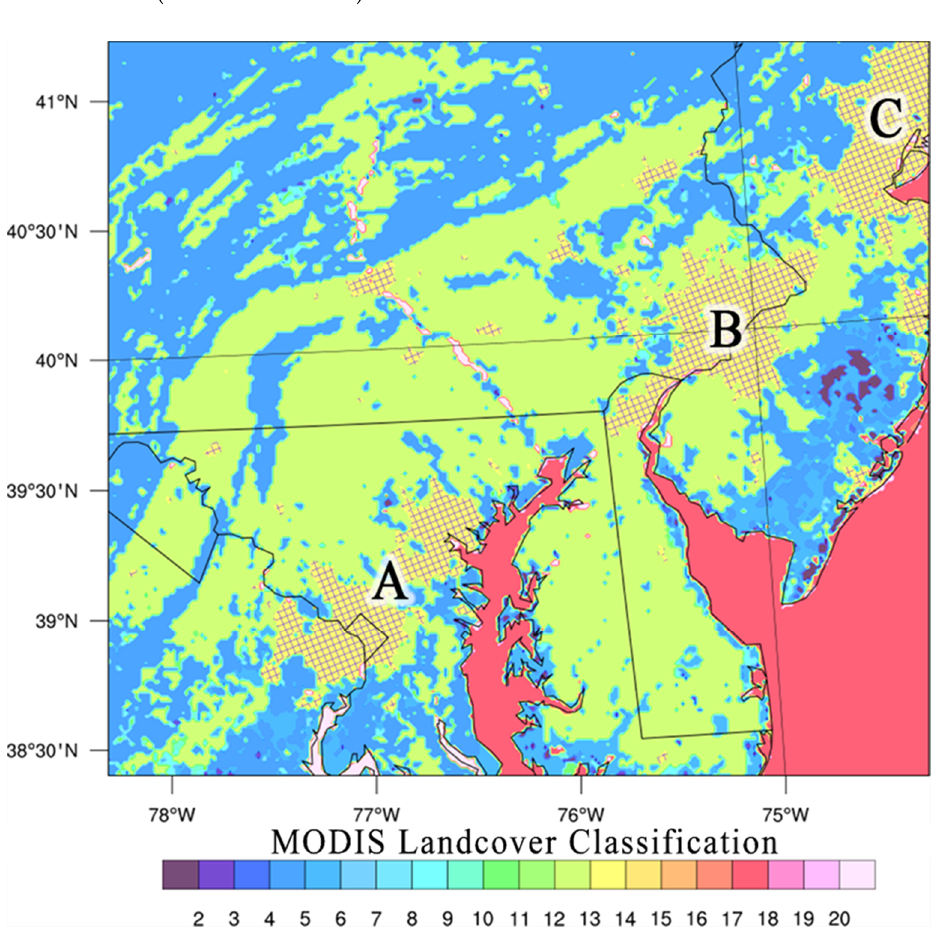
Figure 3. Moderate resolution imaging spectroradiometer (MODIS) land cover classifications over the domain (shown via WRF output variable LU_INDEX). Yellow, cross-hatched areas highlight urban land surface type (MODIS land cover classification No. 13). The labels correspond to each respective urban cluster—DCBAL ( A ), PHLWIL ( B ), and NYC ( C ). Combinations of these clusters are represented in the form A + B or DCPHL. (See Appendix A for descriptions of all MODIS land cover classifications.)